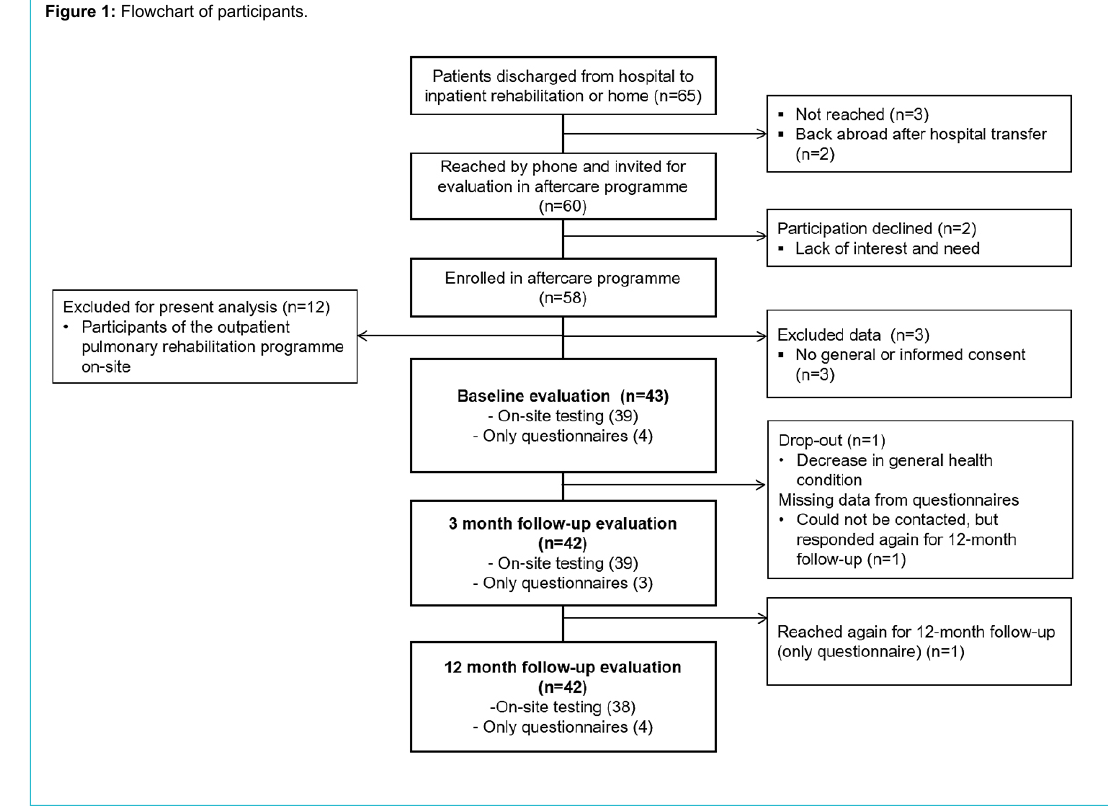
Figure 1: Flowchart of